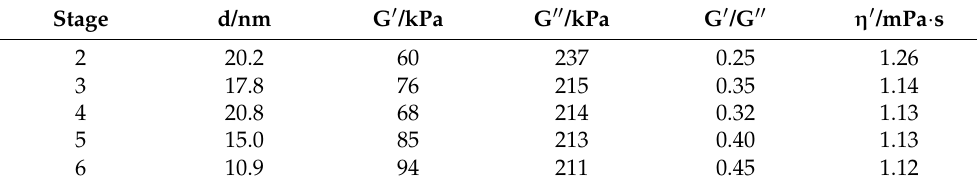
Table 1. Parameters resulting from viscoelastic modeling of the overtone dependence of frequency and dissipation changes measured at the end of Stages 2 to 6 in the experiment shown in Figure 2.